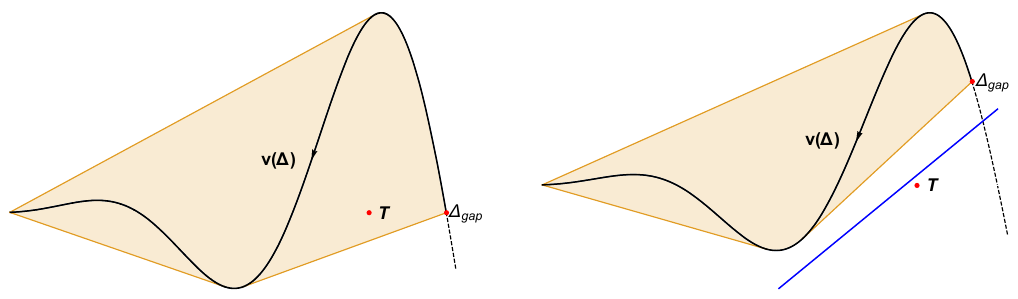
Figure 1 . Feasible vs unfeasible constraints. In black, the line of vectors labeled by the conformal dimension (cid:1). The convex hull H of these vectors includes the target T on the left hand side. On the right it does not, and one can (cid:12)nd a linear functional (the blue line) which separates the target from the remaining vectors.